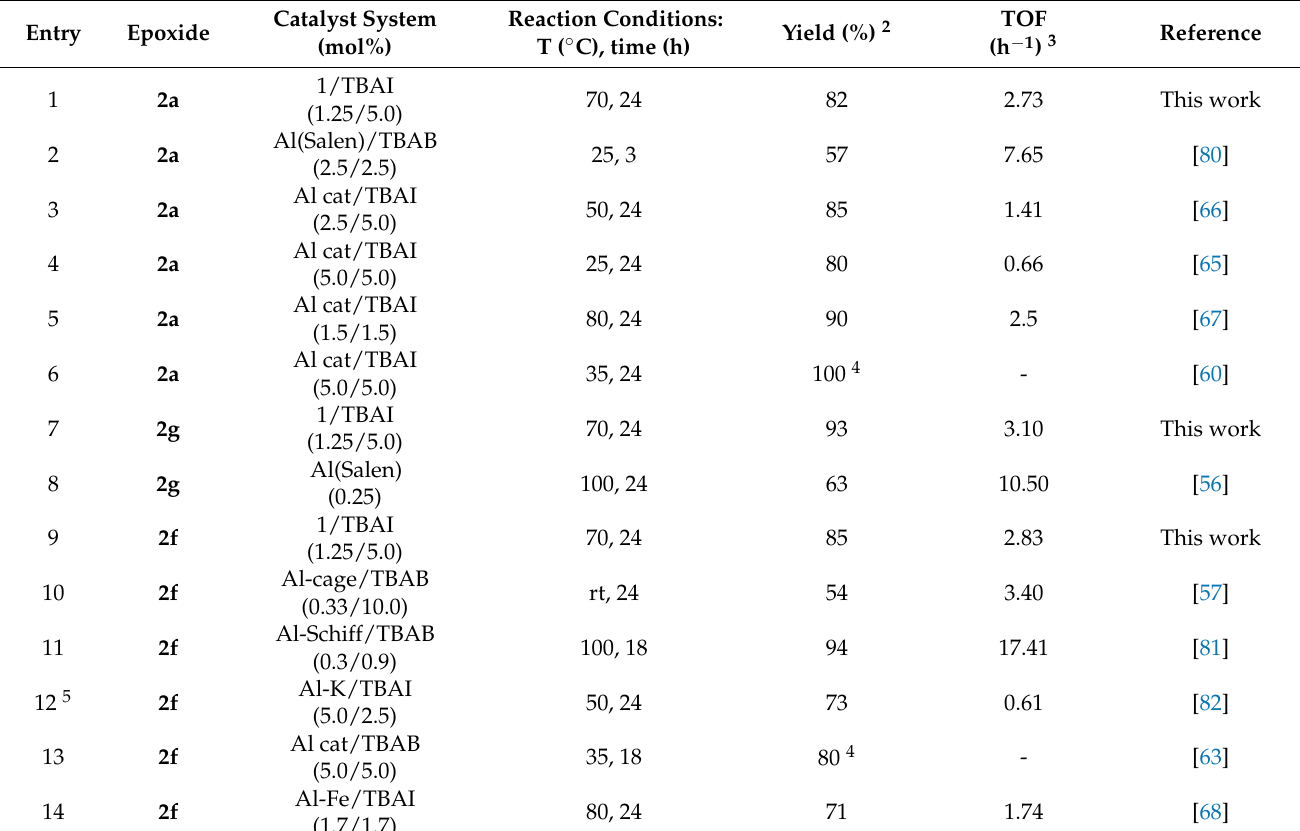
Table 2. Comparison of catalytic activity of different aluminum complexes 1